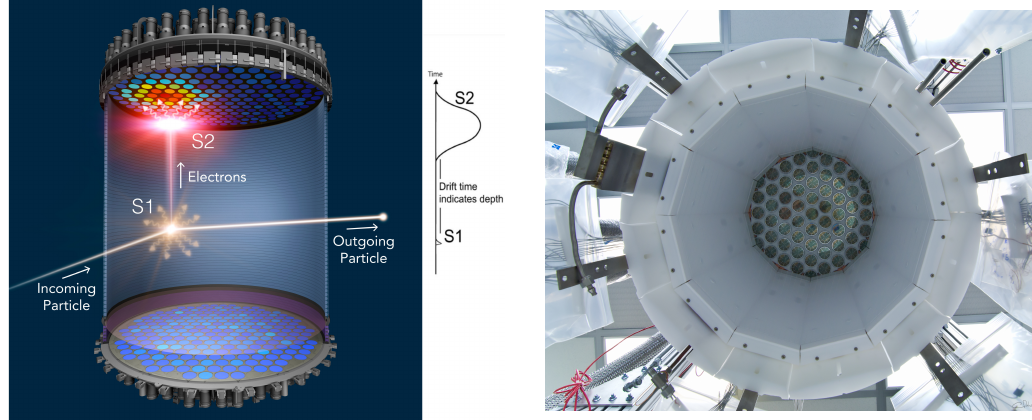
Figure 1. ( Left ) The operating principle of the dual-phase xenon TPC. An electric field is applied along the cylindrical part of the TPC, allowing electrons to drift towards the anode. Each particle interaction in the active LXe produces two signals: the first one comes from the prompt scintillation (S1) and the second one, delayed by the electron drift time, comes from ionisation, by electroluminescence in the gas phase (S2). See text for detail. ( Right ) Photo of the inner part of the LUX TPC, without the bottom PMT